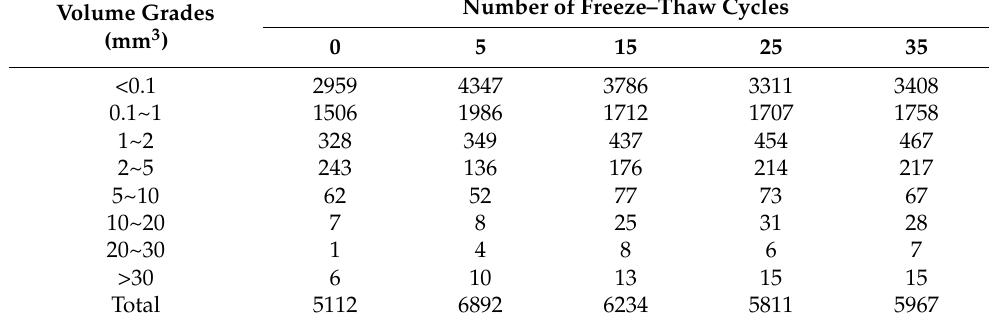
Table 5. Design voids content = 3%.